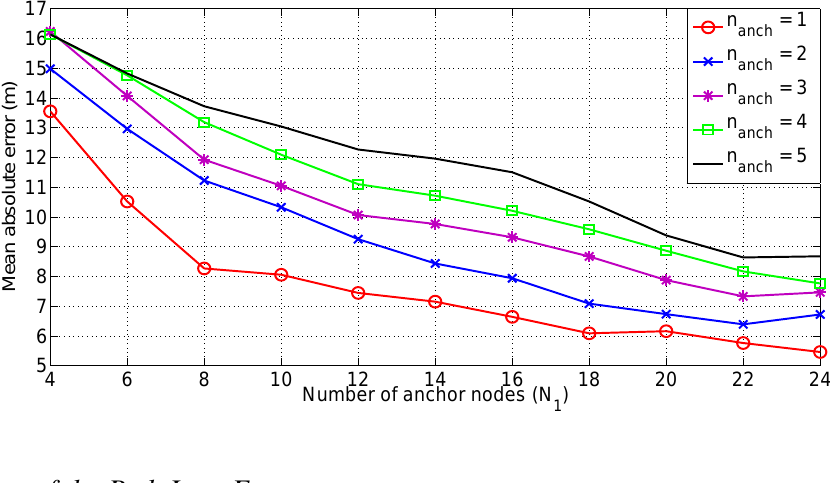
Figure 3. Mean absolute error vs. number of anchor nodes ( N 1 ).